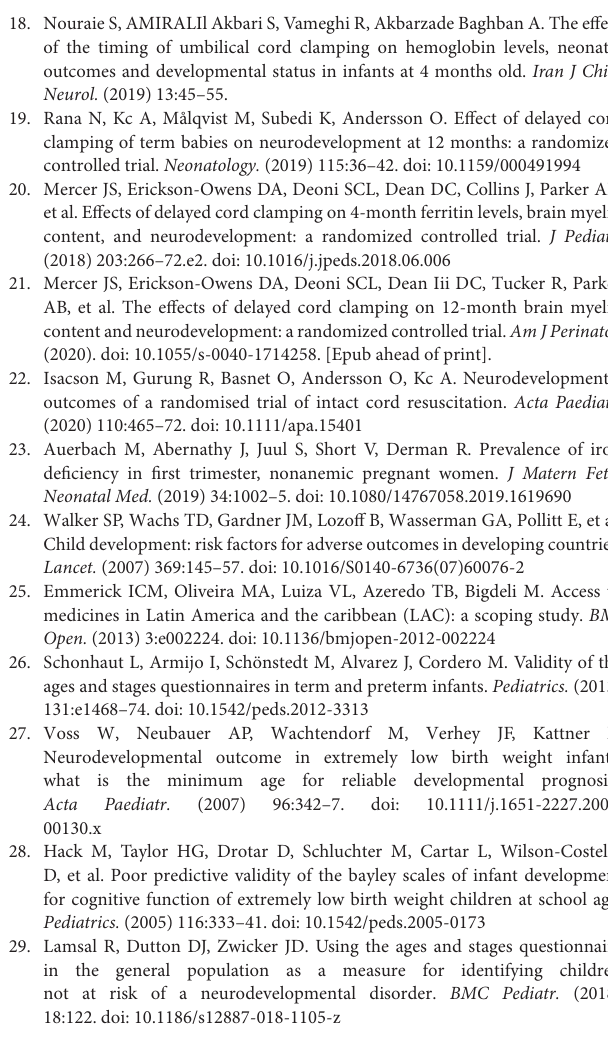
Supplementary Table 2 | Summary of database queries.